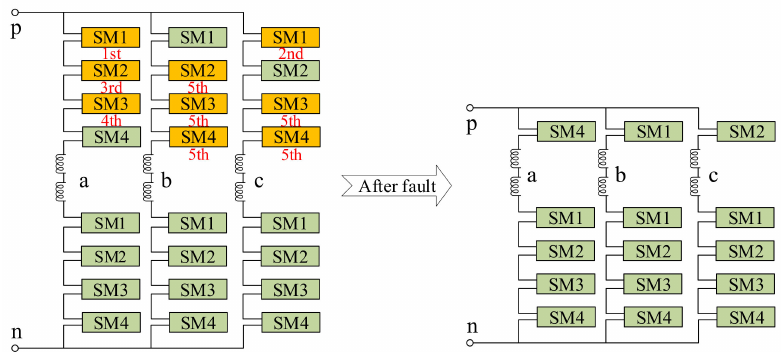
Figure 12. The sequence of sub-module faults and the post-fault equivalent topology.